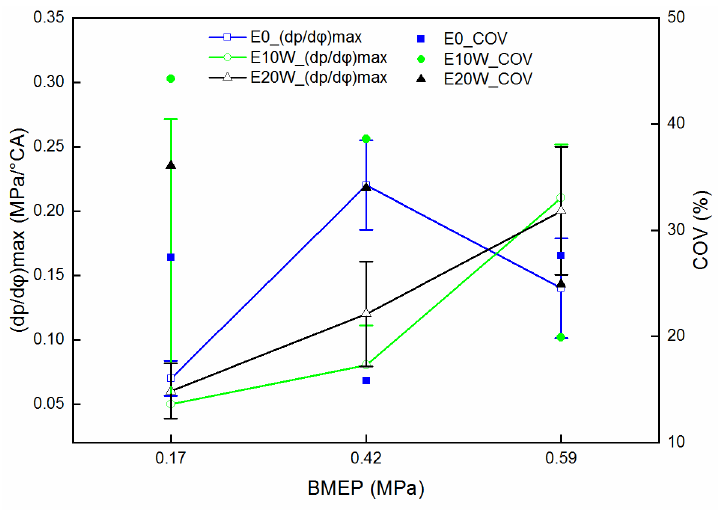
Figure 7. The cycle-by-cycle variations in (dp/dφ) max for E0, E10W and E20W under three various